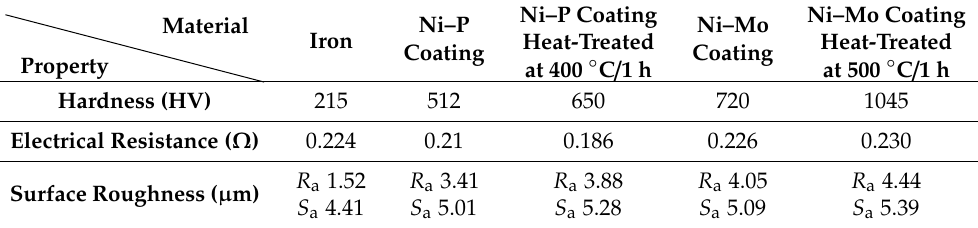
Table 3. Material properties of the experimental rails.